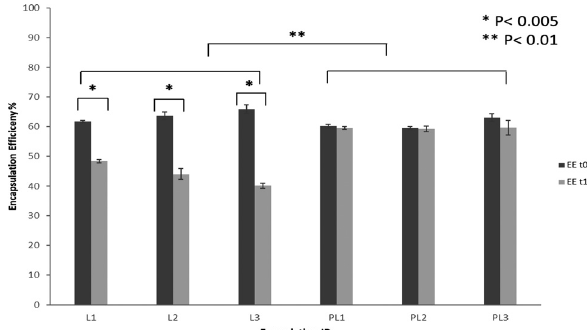
without the ability to dissolve any further amount of drug